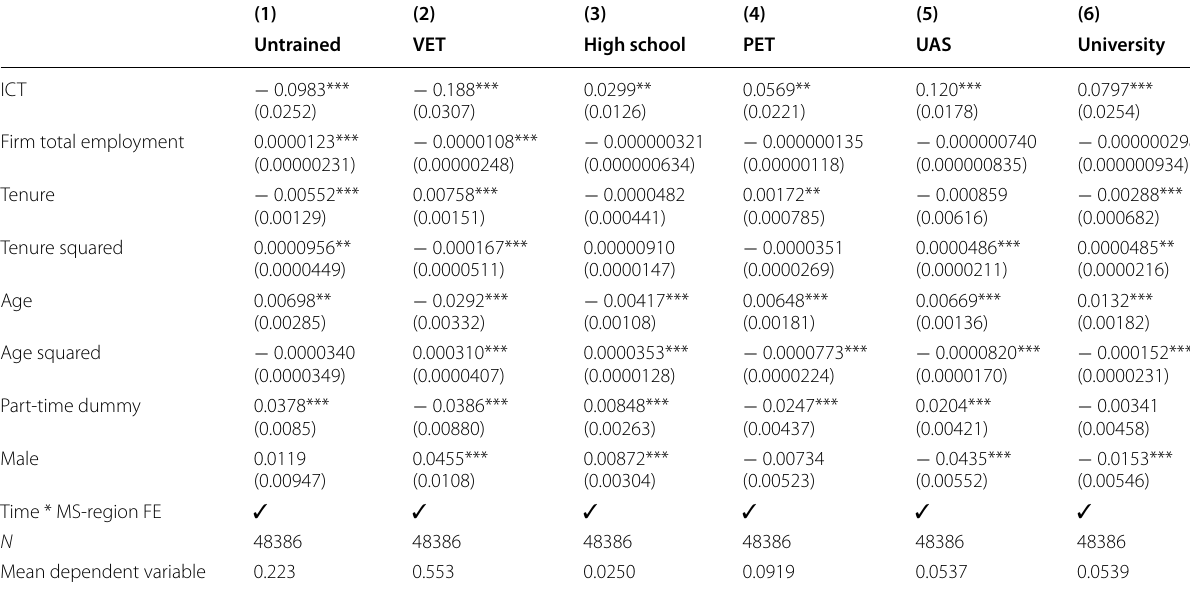
Table 3 Pseudo-panel FE